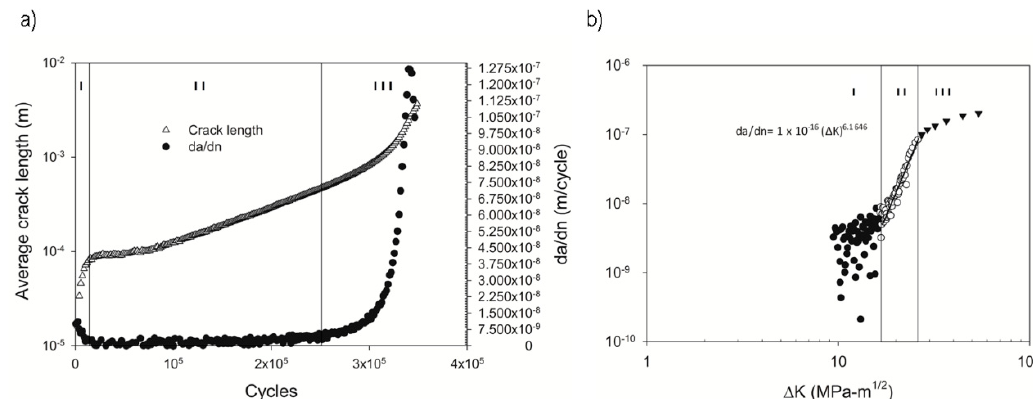
Figure 6. Average crack length and crack growth rate behavior as a function of the cycle number ( a ) and the stress intensity factor range against da / dn ( b ).